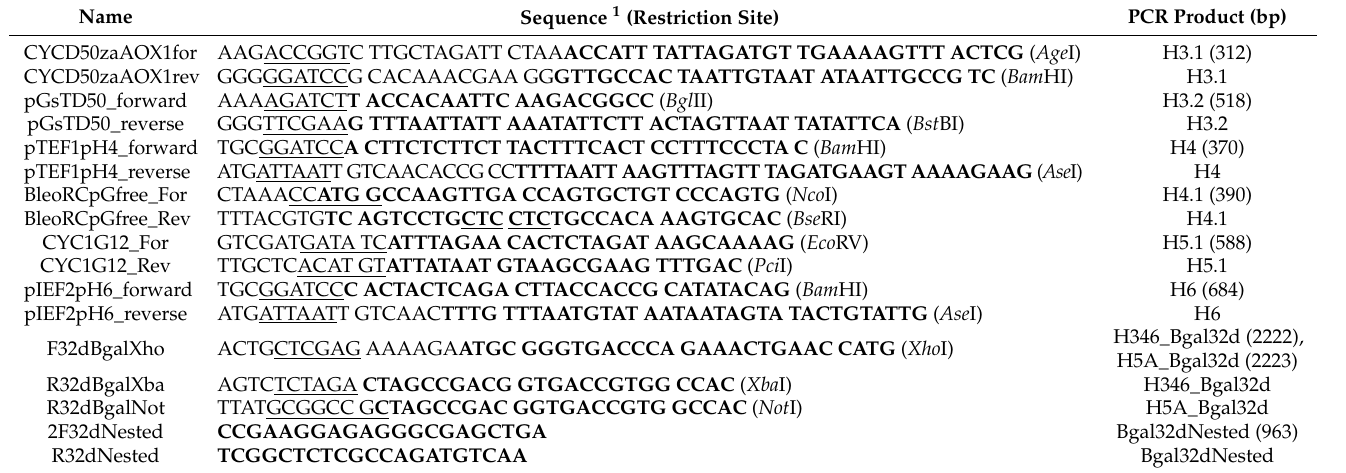
Table 10. Oligonucleotide primers used in this